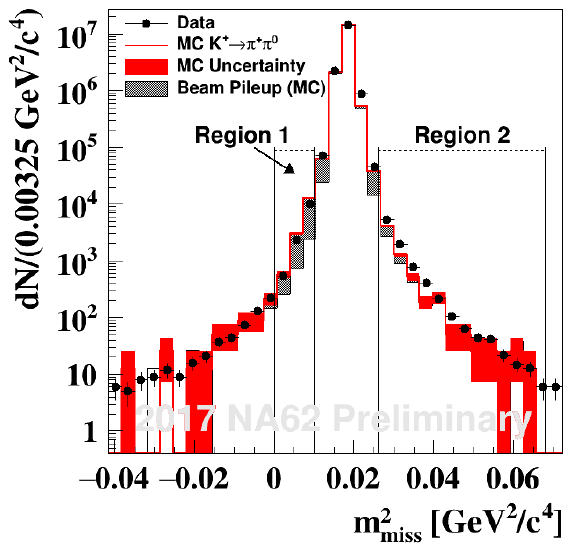
Figure 4. Distribution of m 2 events.